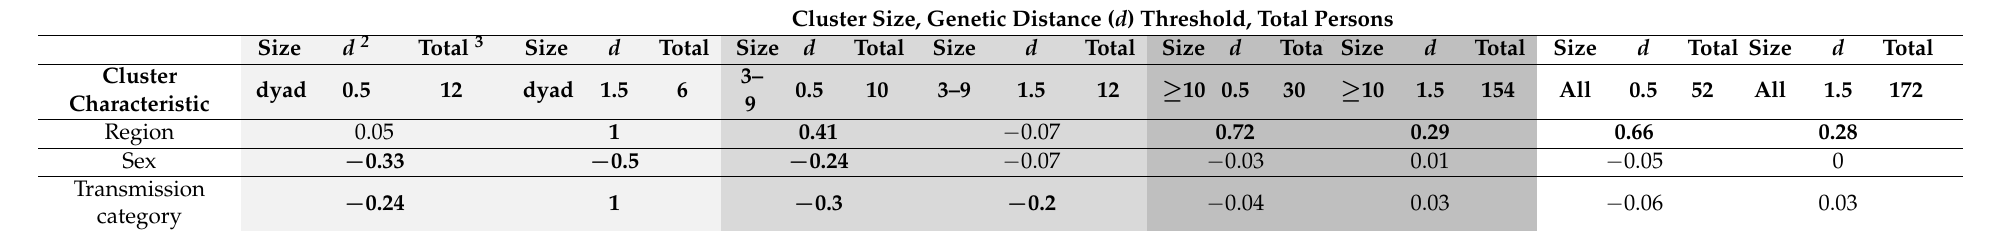
Table 4. Assortative mixing of HIV-1 subtype CRF01_AE clusters in Bulgaria by region, sex, and transmission category 1